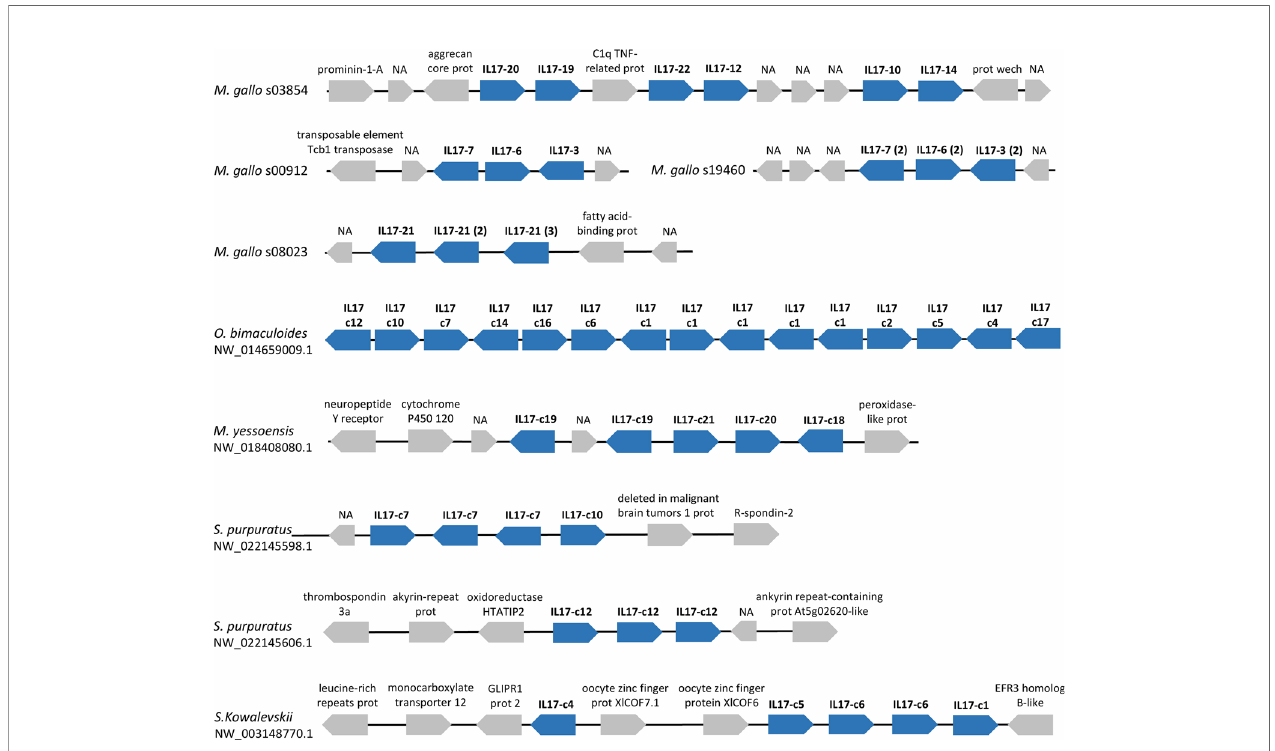
FIGURE 5 | IL-17 genes often appear in tandem repetitions in the genomes of marine invertebrates with expanded IL-17 repertoires. Examples of several scaffolds with IL-17 tandem duplications are presented for these species. IL-17s are indicated with the name of the cluster to which they belong in our analysis. Tandem repetitions can occur with genes from the same or different isoforms. Neighbor genes are represented with their functional